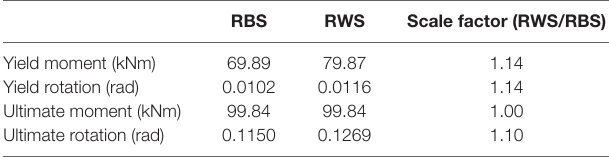
TaBle 7 | Summary of scale factors in reduced beam section (RBS) and reduced web section (RWS)